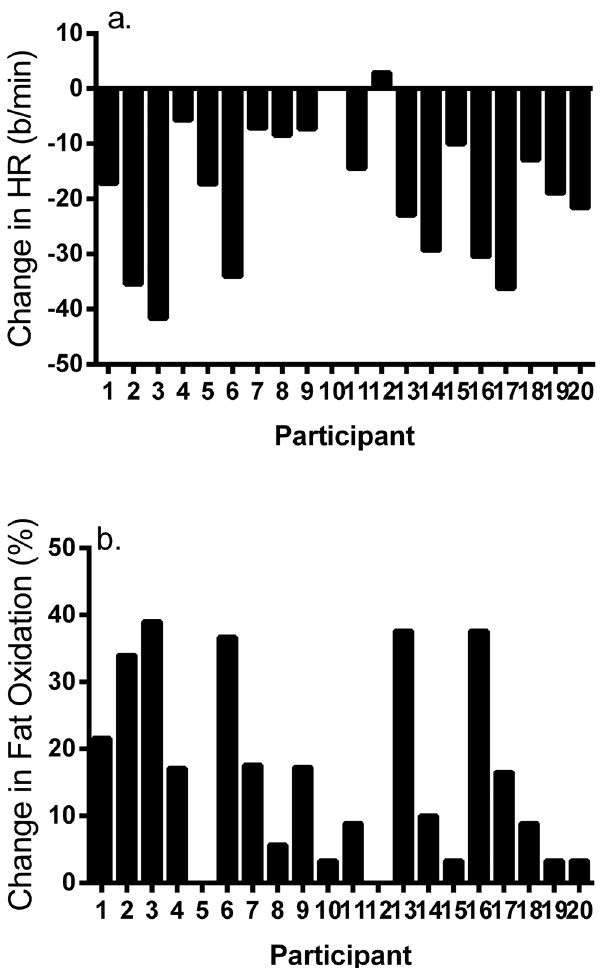
Figure 4. Individual responses for a) change in exercise HR and b) lipid oxidation in response to 12 wk of high-volume interval training.